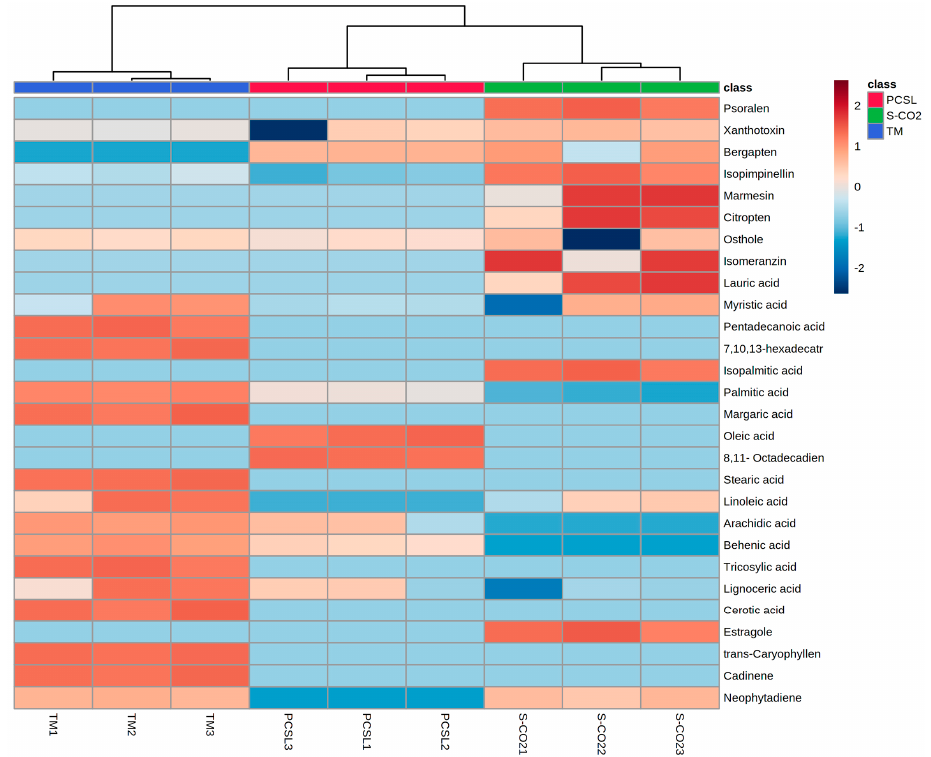
Figure 1. Scores plot ( a ) and loadings bi-plot (PC-1 vs. PC-2) ( b ) of P. ferulacea extracts’ phytochemical profile. Abbreviations are as follows: TM, traditional maceration; PCSL, pressurized cyclic solid–liquid extraction, S-CO 2 : supercritical CO 2 extraction.